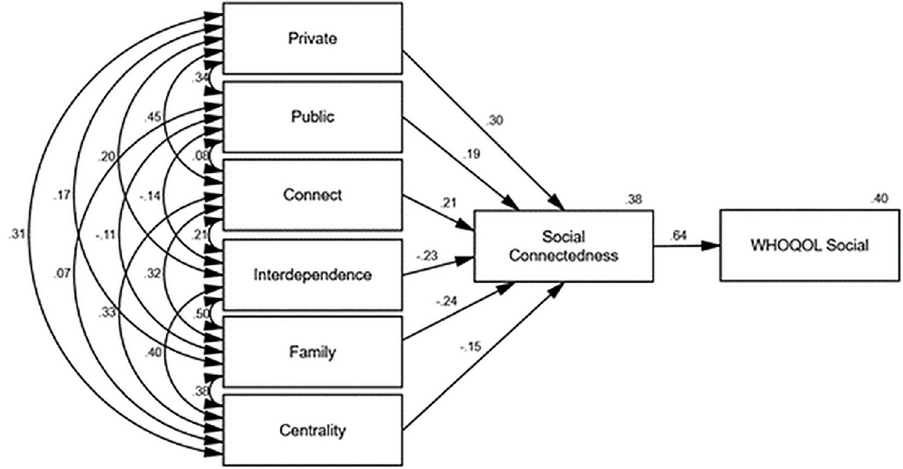
Fig 5. Final path model with standardised parameter estimates WHOQOL-Bref social domain (transformed).